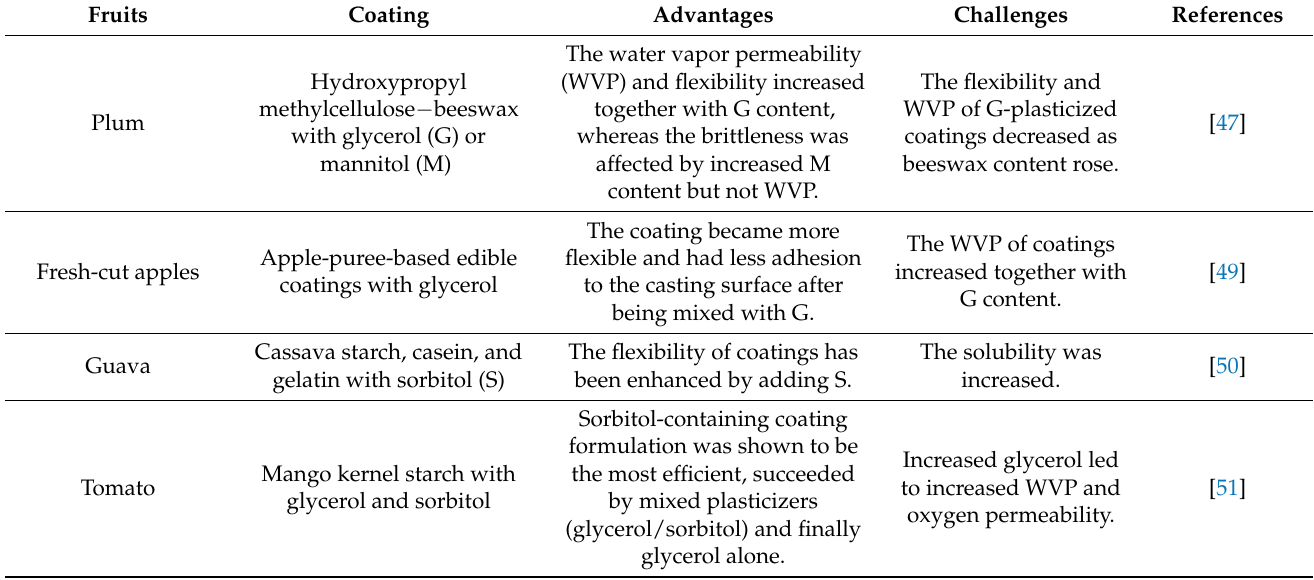
Table 1. Effect of plasticizers on the characteristics of edible